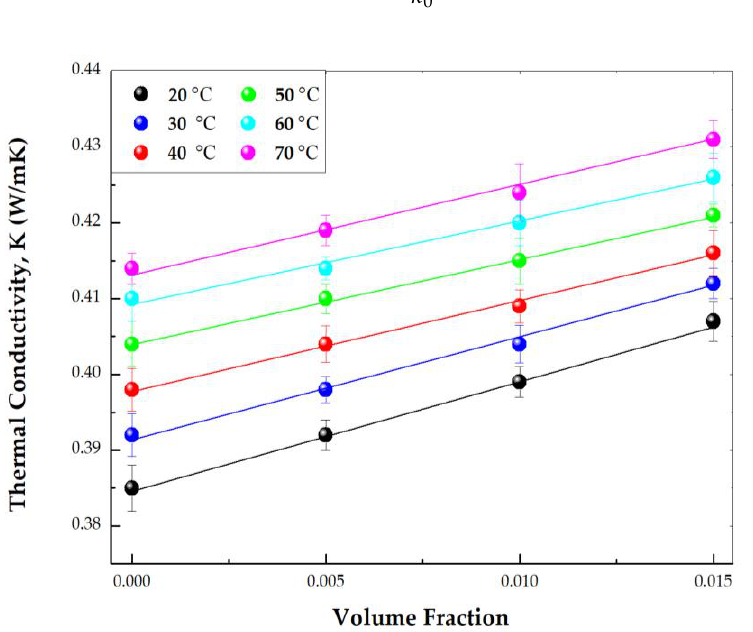
Figure 10. Experimental thermal conductivity versus particle volume fraction of ZnO in 40:60 PG/W nanofluids. Temperature effect.